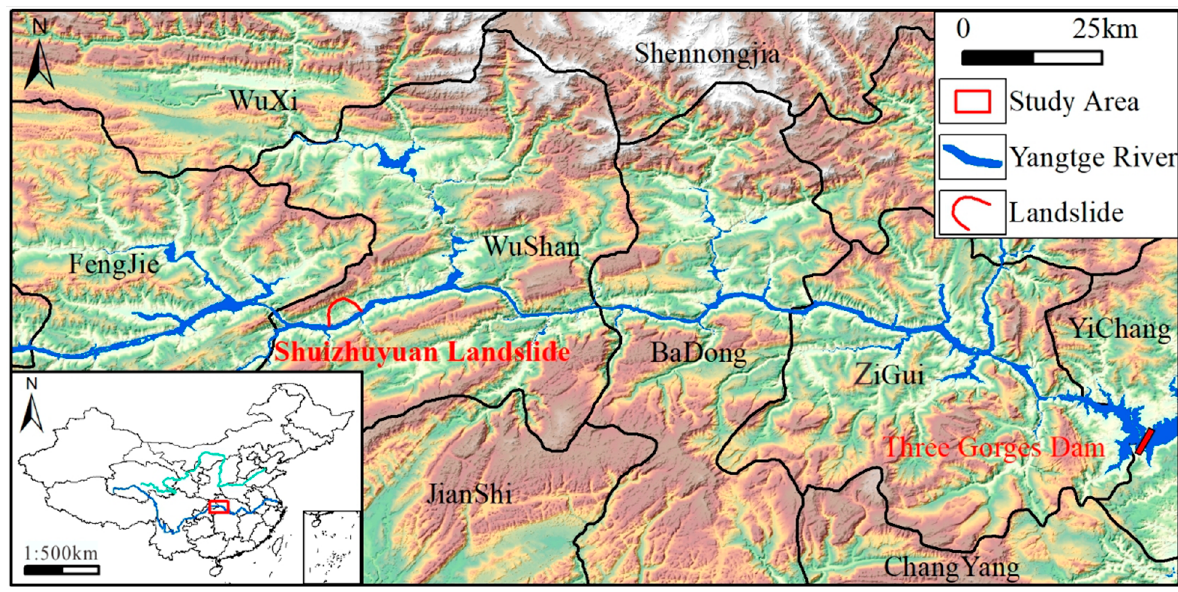
Figure 2. Location of the Shuizhuyuan landslide.